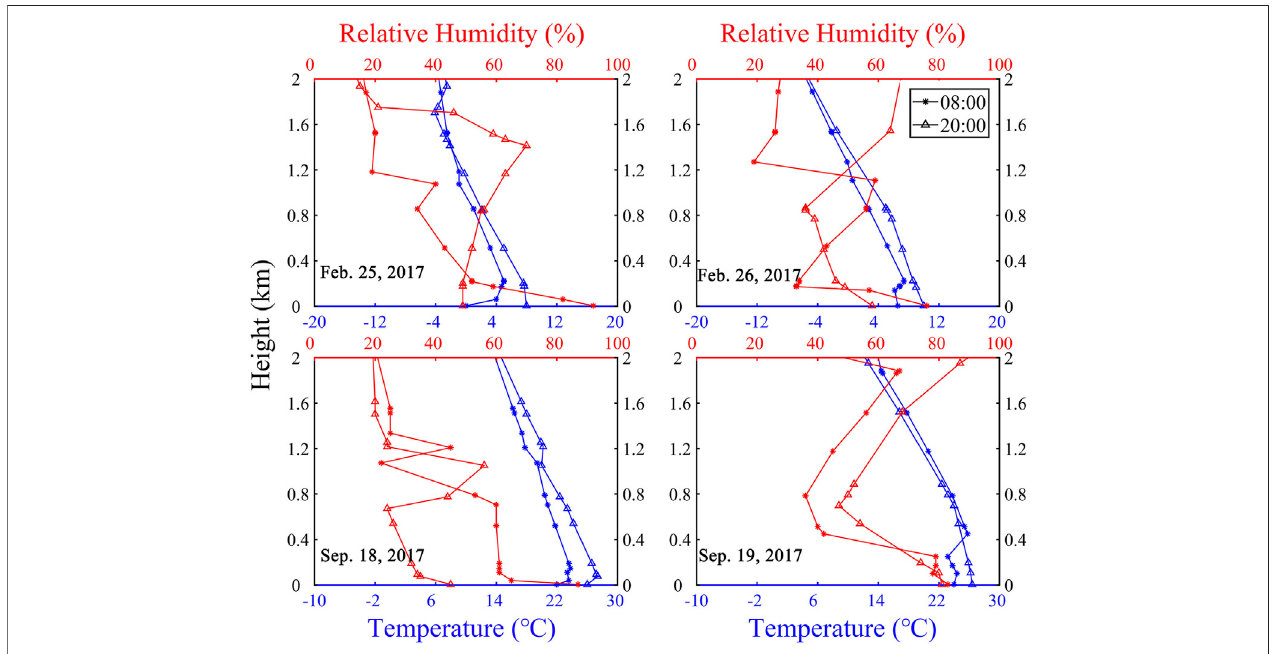
FIGURE 4 | Vertical temperature and relative humidity at Baoshan